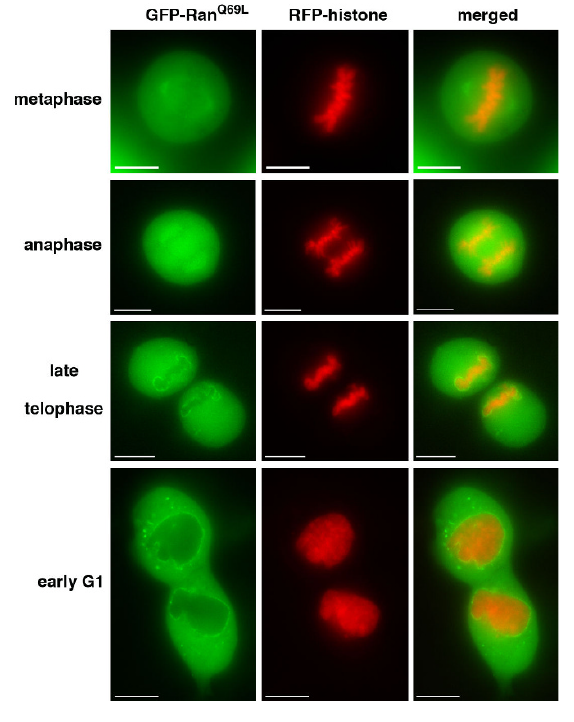
Figure 4 Relocalization of GFP-Ran Q69L during mitosis . Fluores- cence images of live U2OS cells transfected with RFP-histone 2B and GFP-Ran Q69L showing GFP (green), RFP (red) and merged images. Representative images are shown for individ- ual cells during specific phases of mitosis and early G1 that are readily identified by chromosome condensation state and organisation. Scale bars, 10